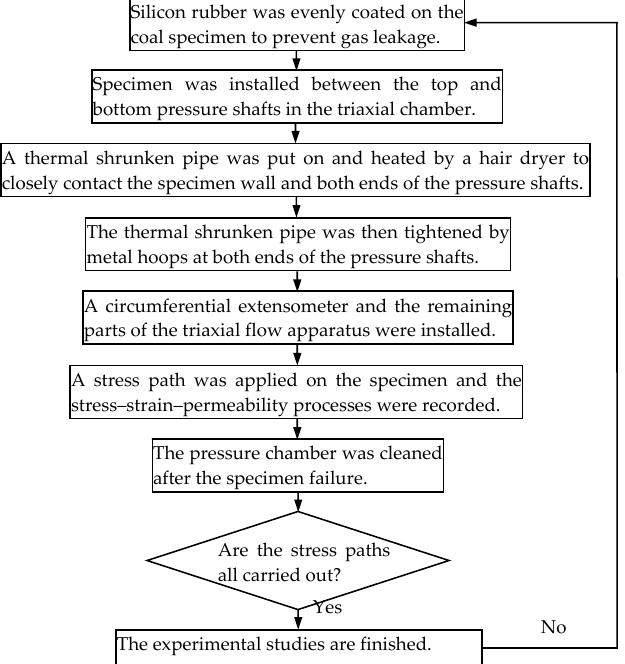
Figure 5. Experiment procedure of the tests.